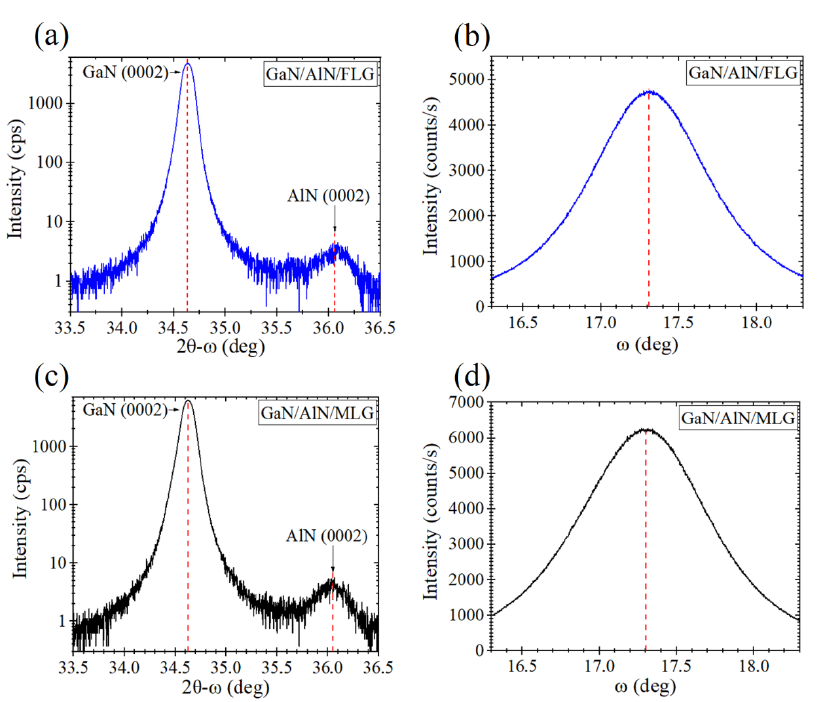
Figure 9. HR-XRD spectra of the experimental samples: ( a , c ) 2 θ - ω scanning curve and ( b , d ) ω scanning curve of the GaN/AlN films grown on the FLG ( a , b ) and MLG ( c , d ).